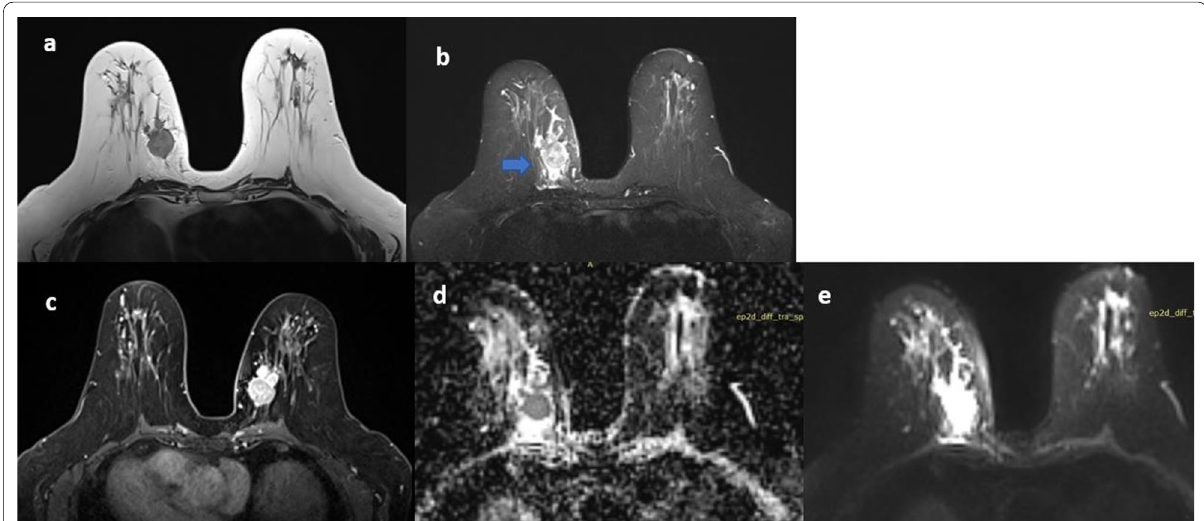
Fig. 6 A 68‑year‑old patient presented for annual screening. Rt. Breast mass pathologically proven to be invasive ductal carcinoma, NOS, grade III and HER 2‑enriched type. ITGB 1 Fc 8.5. a MRI T2WIs hypointense regular mass lesion with circumscribed margin seen at 3 O’clock positions of the = Rt. Breast, with 2 anteriorly located inseparable peri‑lesional satellites, the overall process measuring about (39 the nipple). b MRI T2 WIs fat‑suppressed image shows mild perilesional interstitial edema (arrow) and c T1 fat‑suppression post‑contrast subtracted image displays a right mass lesion with ring enhancement. d DWI shows restricted diffusion. e Low ADC values (ADC value seen. Normal MRI appearance of the left breast